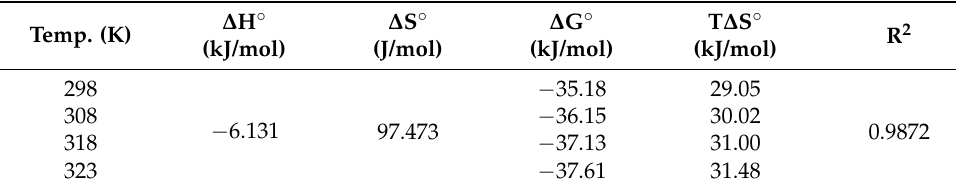
Table 4. Thermodynamic parameters for UO 22+ sorption.